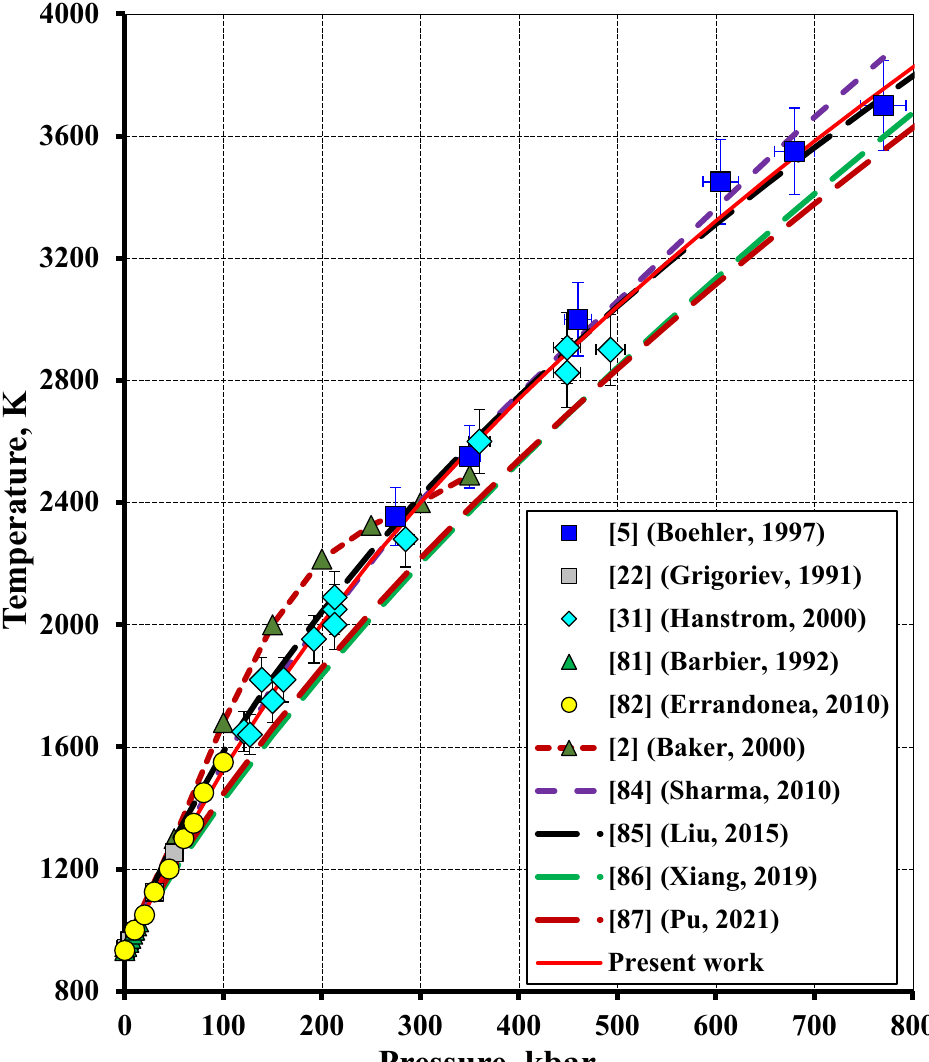
Figure 8. The calculated melting curve of aluminum as compared to experimental [5,22,31,81,82], calculated [2] and theoretical data [84–87].